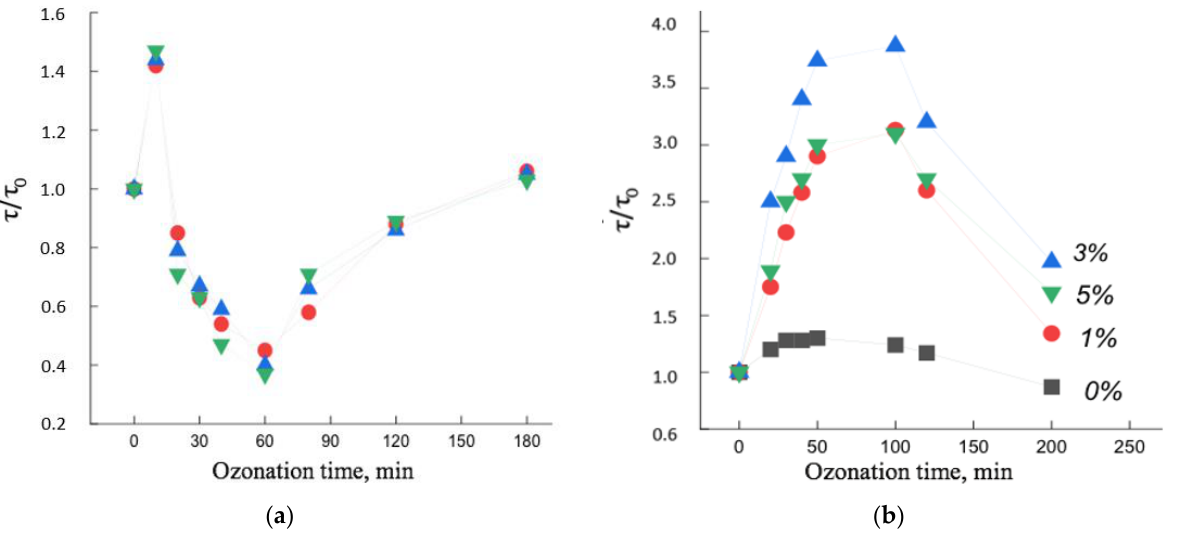
Figure 9. Change in molecular dynamics τ/τ 0 as a function of ozonation time in PHB fibers with metal complexes: ( a ) hemin, ( b ) Fe(TPP)Cl: 1 — 0%, 2 — 1%, 3 — 3%, 4 — 5%.